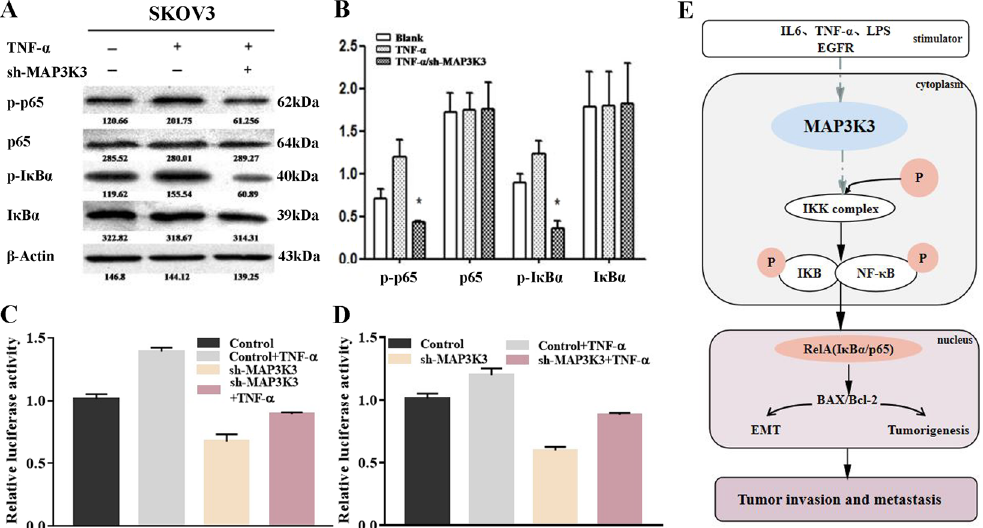
Figure 4. Effect of MAP3K3 on the NF - κ B signalling pathway. ( A , B ) Western blot to detect the inhibitory effect of MAP3K3 on NF- κ B signalling in SKOV3 cells through different treatments of TNF- α (without/adding TNF- α /adding TNF- α + sh-MAP3K3). Detection of NF- κ B signalling pathways in different cell treatment groups (Control/TNF-a/sh-MAP3K3/sh-MAP3K3 + TNF-a) in SKOV3 cells ( C ) and A2780 cells ( D ) by the luciferase reporter assay. Summary diagram showing cooperation between MAP3K3 and NF- κ B-EMT signalling-related protein expression in OC ( E